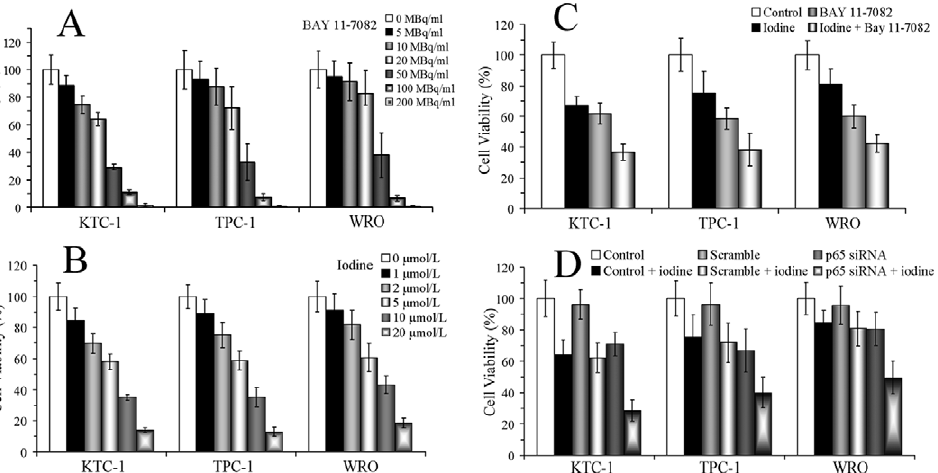
Figure 1. Cytotoxic effects of 131 I, Bay 11-7082 and siRNA therapies on thyroid cancer cells. After exposure to indicated concentrations of Bay 11-7082 (A), activity concentrations of 131 I ( B ) or combined therapies ( C ) for 48 hours, cell viabilities were determined by MTT assay. After DTC cells were treated with no oligonucleotide control, scrambled oligonucleotides or p65 siRNA transfection, cells were transferred to 96-well plates. Then cells were treated with or without 131 I (20 MBq/ml) for 48 hours, and MTT was performed ( D ). Similar results were obtained in three independent experiments.